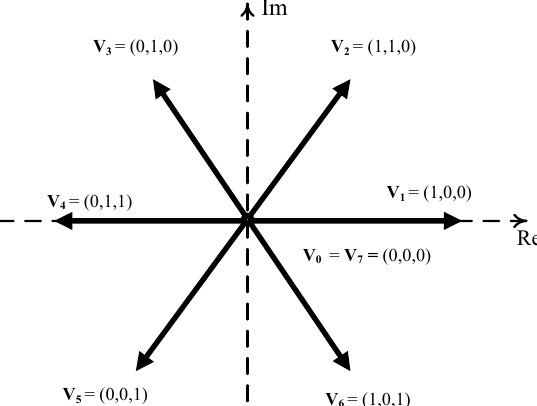
Figure 3. Voltage vectors. Notes: Re { v apf } = v apf α and Im { v apf } = v apf β